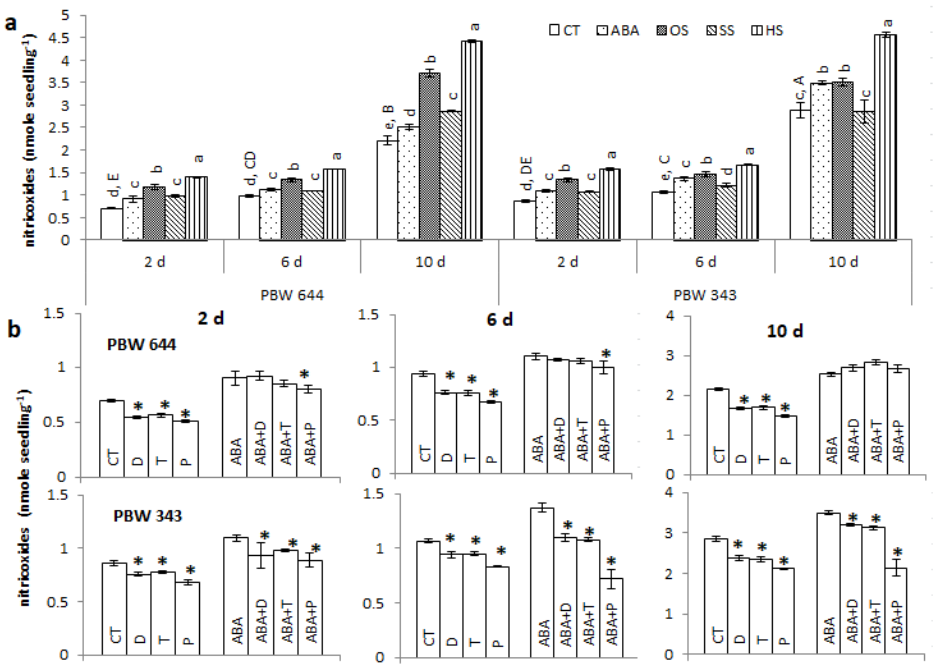
Figure 6 - Change of nitric oxide content ( a ) and ROS/NO regulation of nitric oxide ( b ) during post- germination desiccation and rehydration in wheat cultivars PBW 644 and PBW 343. Rest is same as in Fig. 1 for a and Fig. 2 for b .